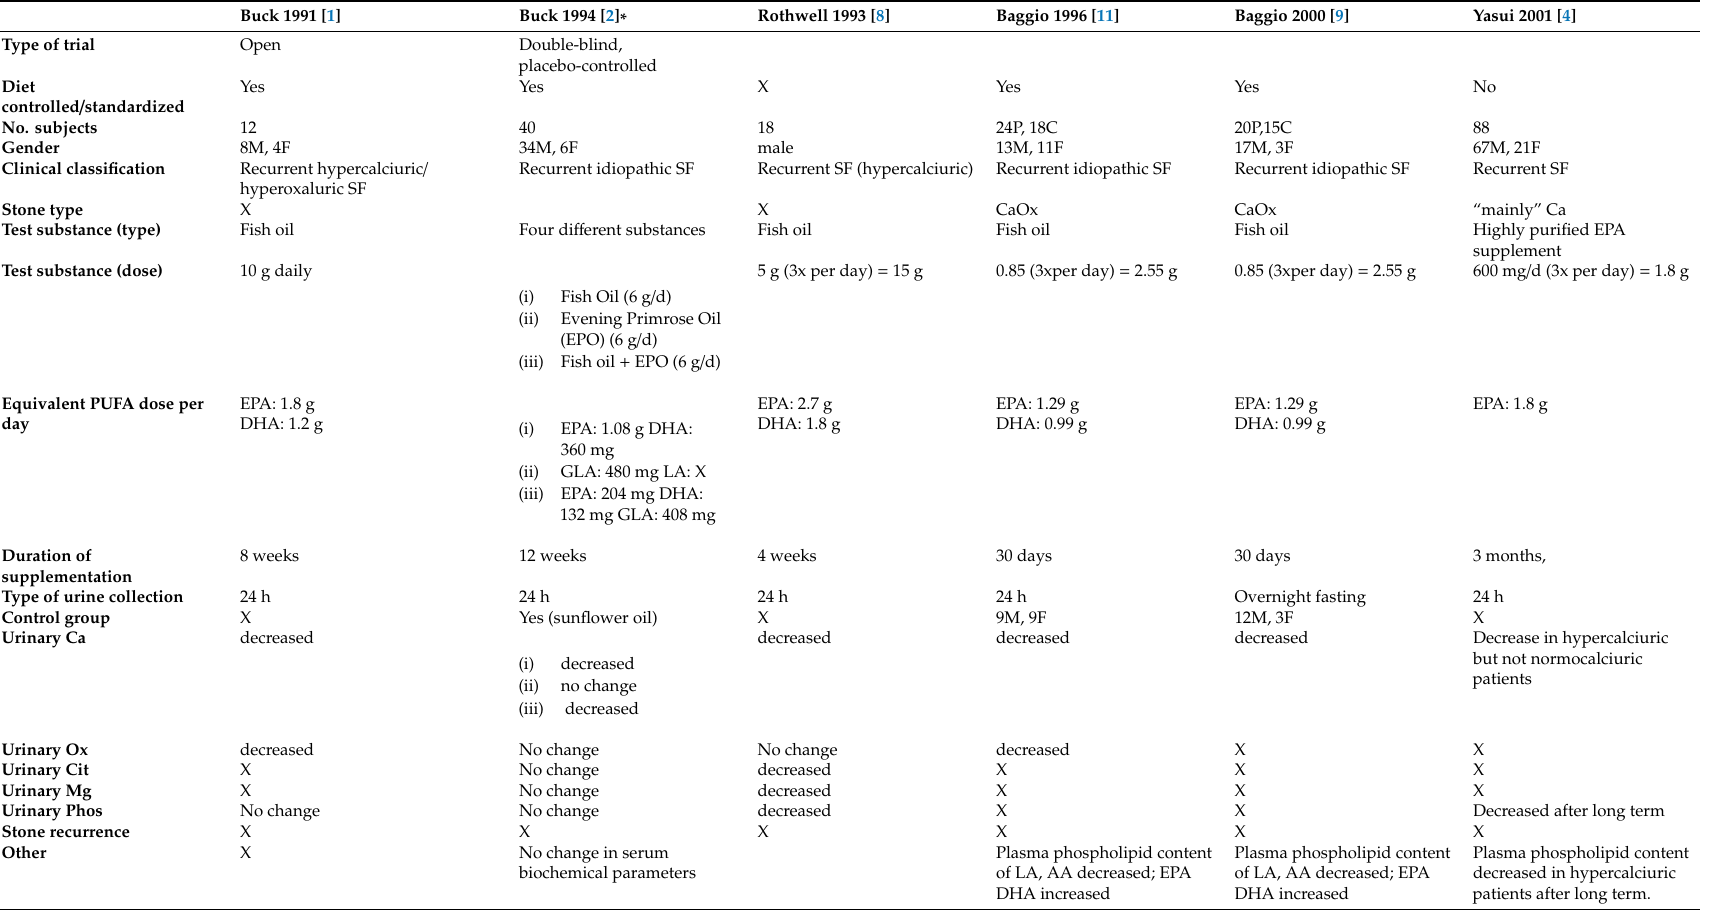
Table 1. Human trials investigating the e ff ect of n-3 and n-6 polyunsaturated fatty acid ingestion on renal stone formation risk